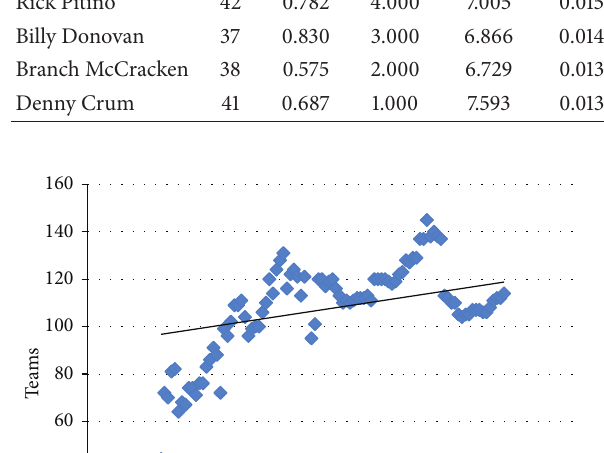
Table 8: Ranking result.